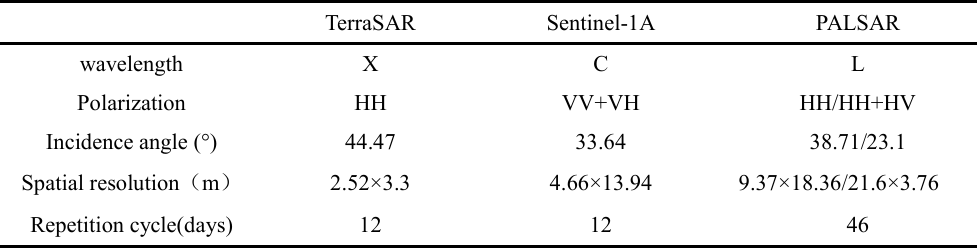
Table 1 Characteristics of three kinds of SAR data used in this study